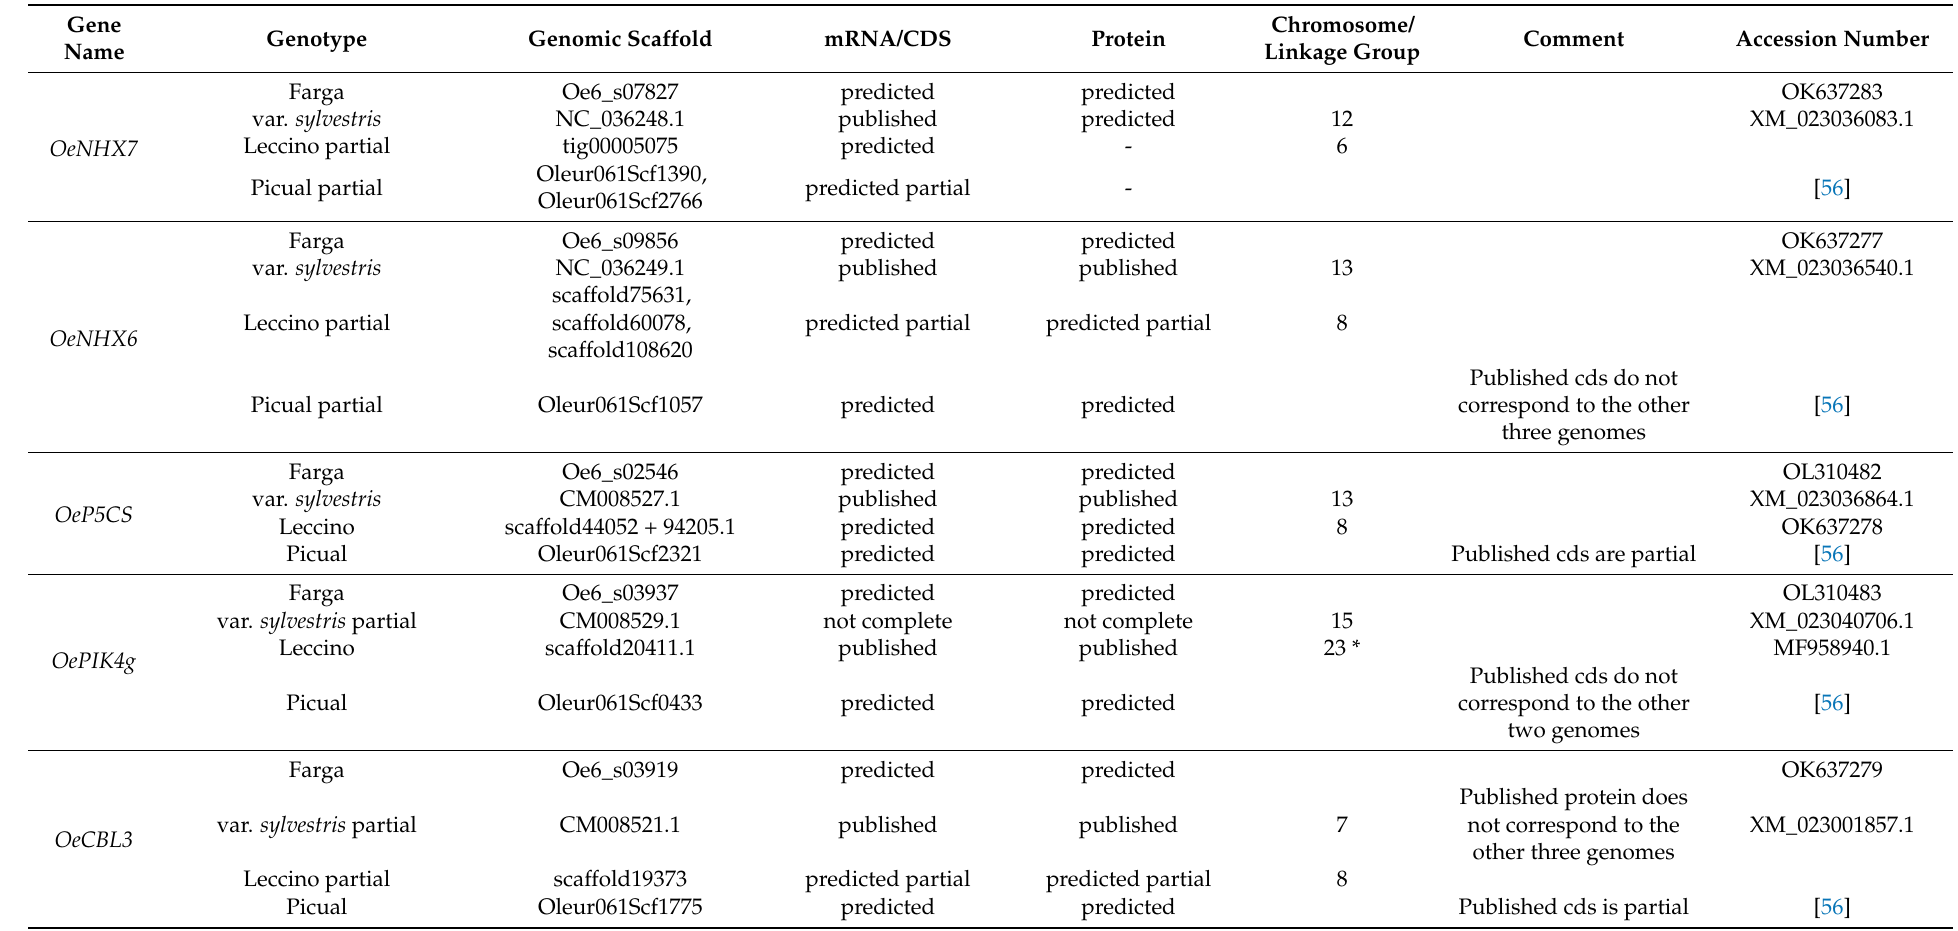
Table 1. Identified genes and corresponding transcripts, proteins and chromosome position in Olea europaea cv. Leccino